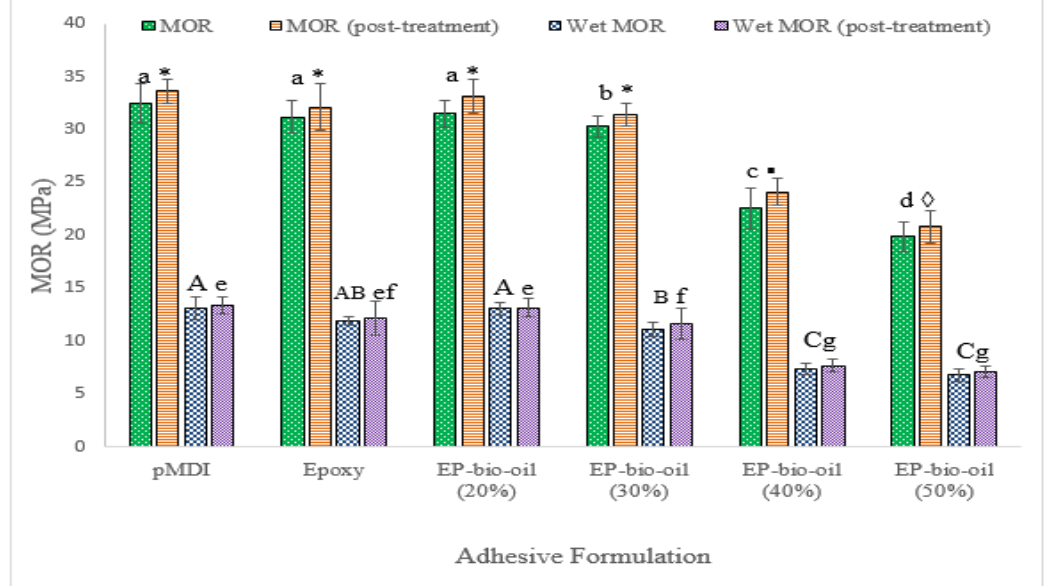
Figure 6. Modulus of rupture (MOR) of OSB bonded with epoxy resin and epoxy-substituted bio-oil at 20%, 30%, 40%, and 50% bio-oil contents. Wet MOR was analyzed separately. EP-bio-oil (%): epoxy resin substituted with bio-oil. Different letters and symbols on the bar represent significant MOR ( p < 0.05). Post-treated means were analyzed separately. Error bars represent standard deviation.